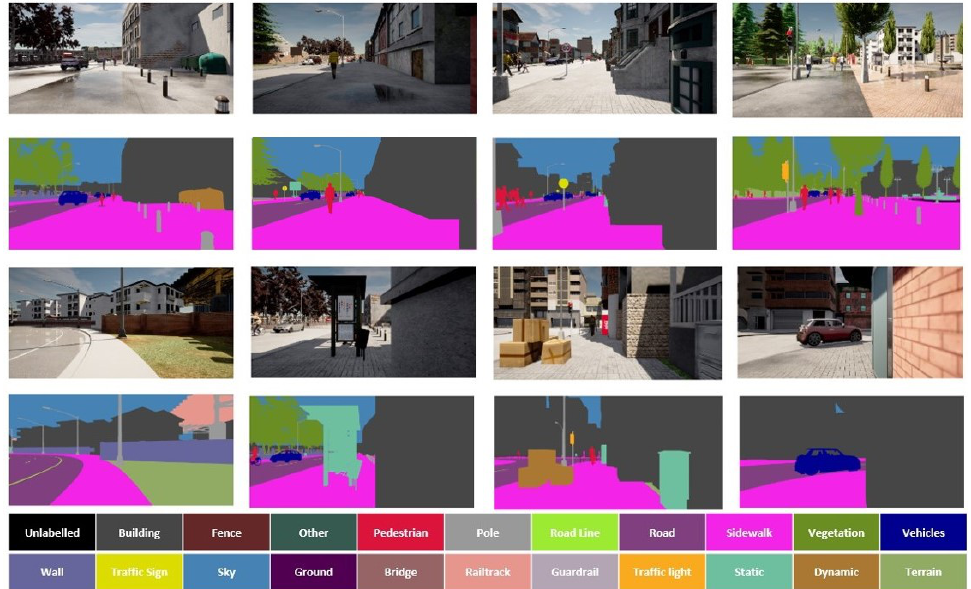
Figure 1. The first and third rows show some sample video frames from our agent in the CARLA urban sidewalk environment. The second and fourth rows illustrate finely annotated RGB segmenta- tion ground truths for each corresponding frame in the upper row. The annotations are for 22 classes, as per class names and colour labels as shown in the palette. These include all the groups from the Cityscapes dataset, with an additional three classes as road lines, guard rails and static